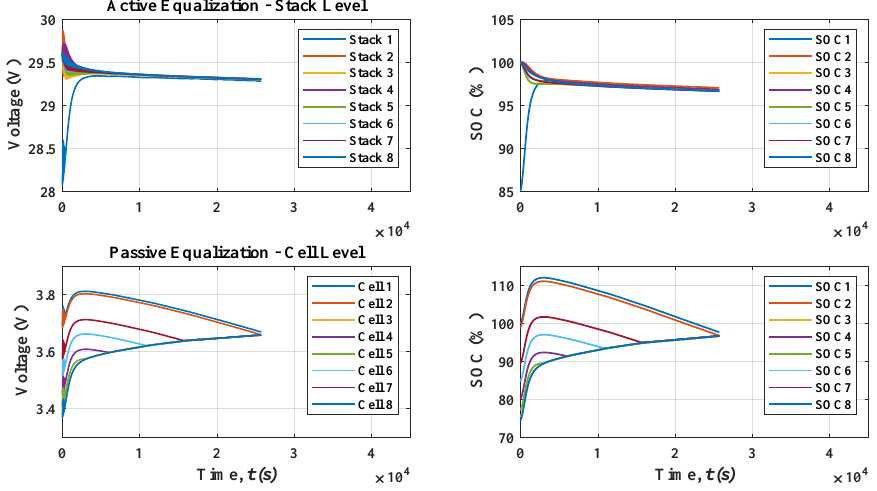
Figure 10. Hybrid equalization: active stack level and passive cell level. Based on the results obtained in the simulations, the use of two different equalization topologies, passive and active, can be used in practice in projects with restrictions on the volume available in the battery pack casing. For example, in the configuration of the simulated pack in this work, which was based on an actual research and development project at the Federal University of Technology—Paraná, the sixty-four cells in series are divided into eight stacks. To apply a purely active topology, the number of electronic components is significant, such as inductors, MOSFETs, and control circuits. In this way, it would not be possible to develop eight slave modules for each stack, because the physical space available in the casing is restricted. The solution is to use slave modules with the passive equalization technique. An example of a compact commercial integrated circuit is the BQ79656-Q1 from Texas Instruments. From the simulated results, applying the active topology only to equalize the voltage difference between the stacks, the energy